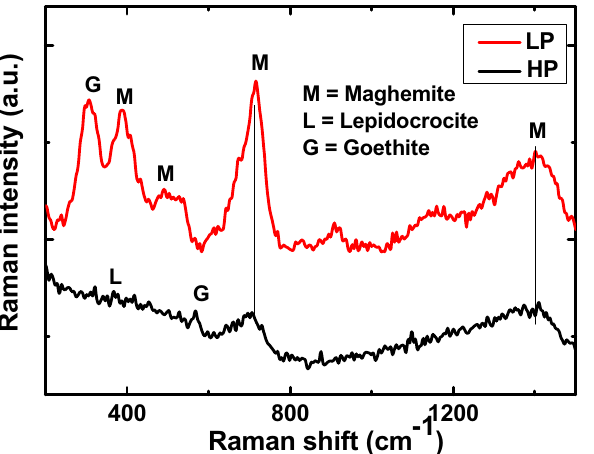
Figure 22. Raman spectra of rust formed on steel rebars embedded in mortar after 10 cycles of wet/dry treatment in chloride